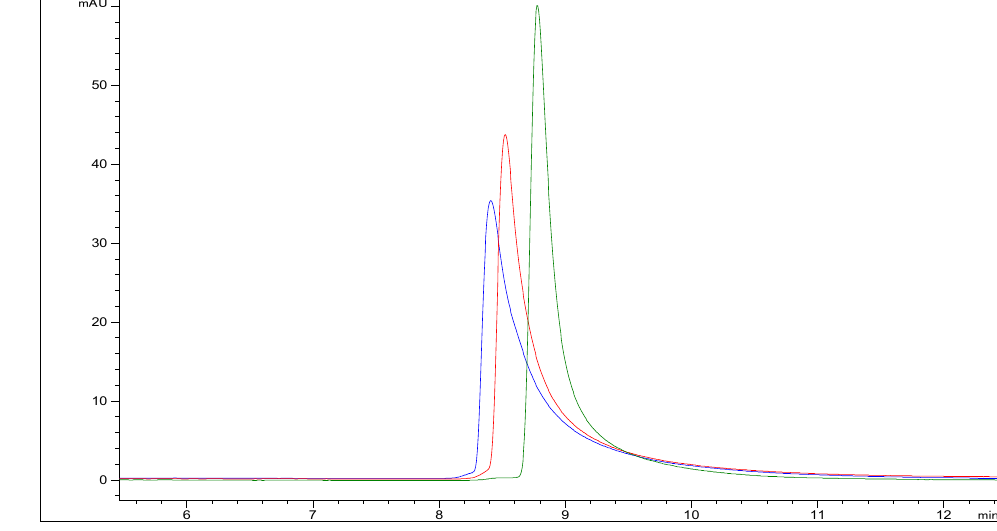
Figure A3. The effect of NaCl concentration in the mobile phase on Lf peak shape:  0.0 M NaCl,  0.05 M NaCl,  0.25 M NaCl, and  0.5 M NaCl. Separation was performed on Zorbax 300SB- C3 column at 35 °C using 0.1% TFA and NaCl in water (A) and acetonitrile (B) as a mobile phase at a flow rate of 1.0 mL/min. The gradient program is described in Section 2.2.